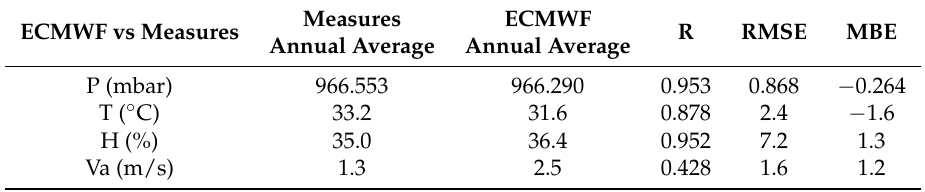
Table 2. Annual averages, correlation coefficient (R), Root-mean-squared error (RMSE), and mean bias error (MBE) of the site measured pressure (P), temperature (T), humidity (H) and wind speed (Va) in comparison with ground meteorological parameters extracted from European Center for Medium-Range Weather Forecasts (ECMWF) data in Maroua in